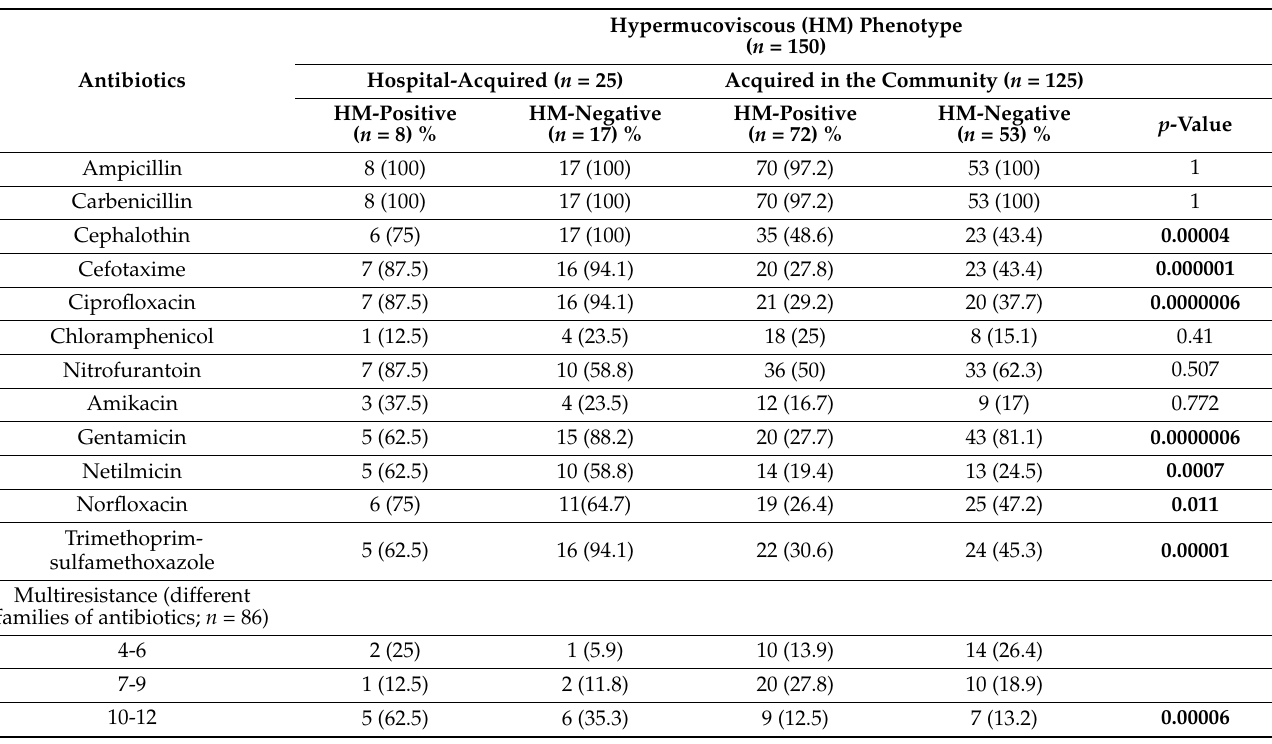
Table 3. Resistance and multiresistance to antibiotics according to hypermucoviscous phenotype (HM) in strains of K. pneumoniae isolated from patients with hospital- and community-acquired infections. Hypermucoviscous (HM) Phenotype ( n = 150) Hospital-Acquired ( n =